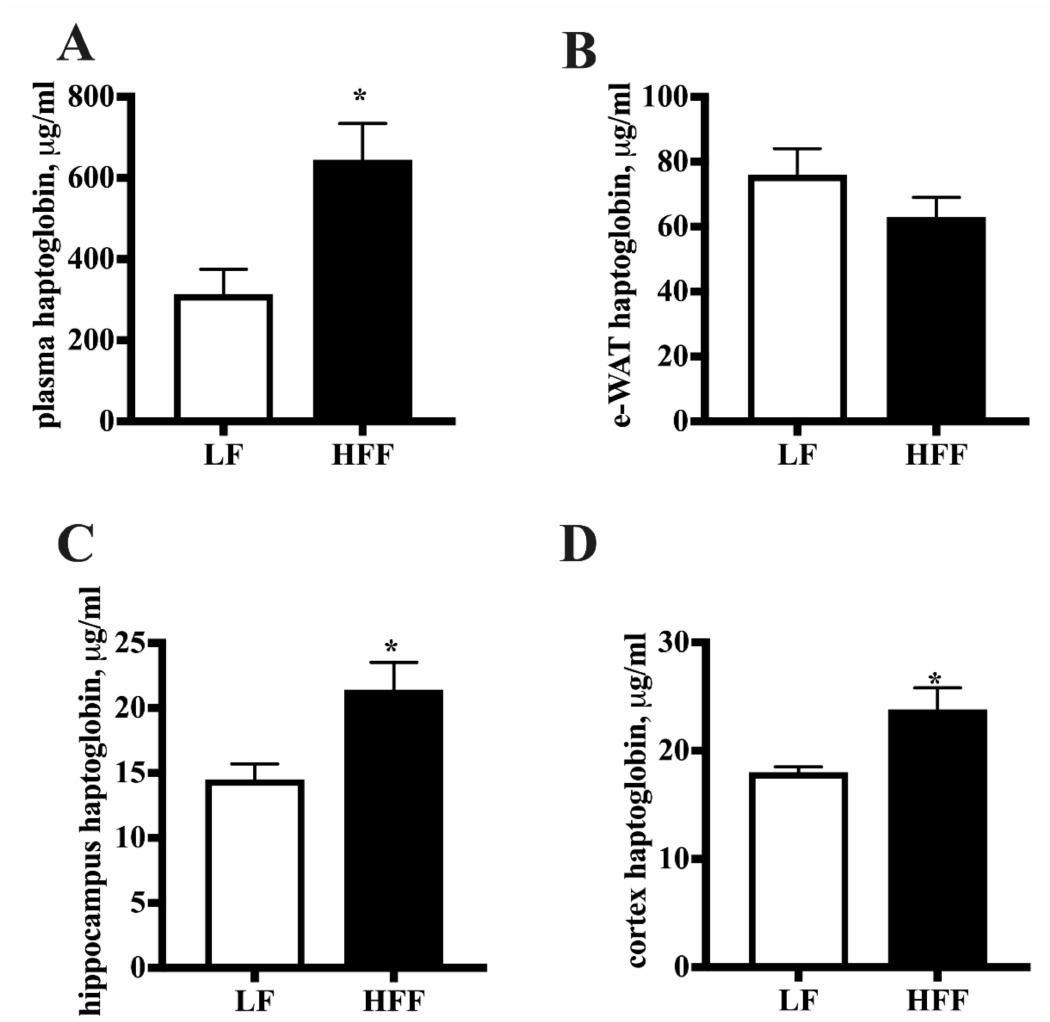
Figure 6. Levels of haptoglobin detected by enzyme-linked immunosorbent assay in plasma ( A ), epididymalwhiteadiposetissue(e-WAT)( B ),hippocampus( C ),andfrontalcortex( D )frommiddle-aged rats fed low fat (LF) or high fat-high fructose (HFF) diet for four weeks. Values are the means ± SEM of eight rats. * p < 0.05 compared to low-fat diet (two-tailed Student’s